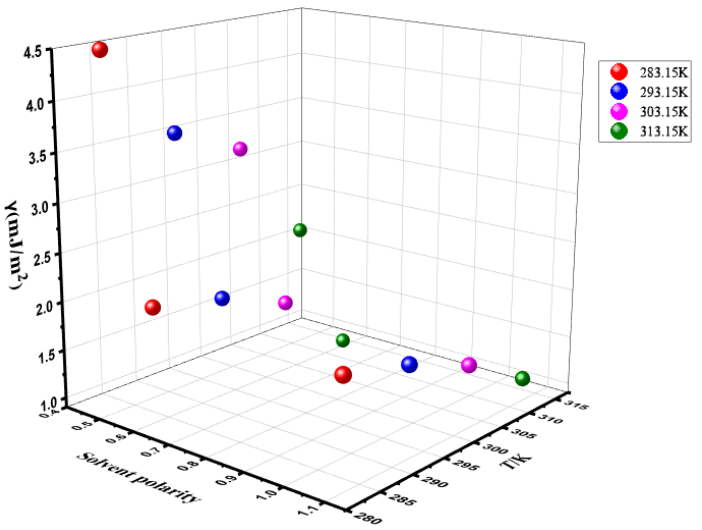
Figure 7. Relationship between γ and saturation temperature and different polar solvents. Table 5. Value of nucleation kinetic parameters calculated by Equation (5).